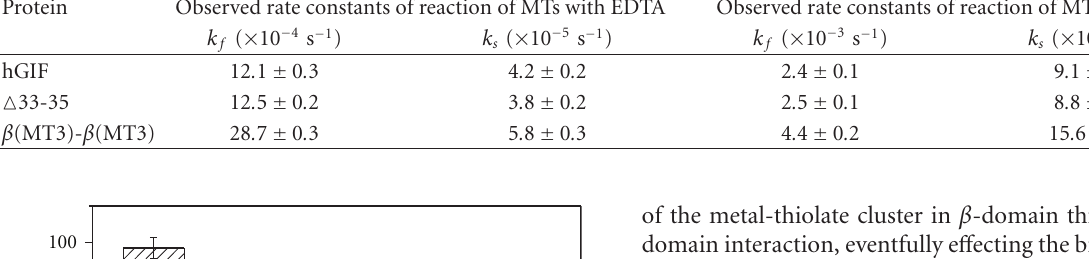
Table 2: Observed rate constants of reaction of MTs with EDTA and DTNB. Protein Observed rate constants of reaction of MTs with EDTA Observed rate constants of reaction of MTs with DTNB